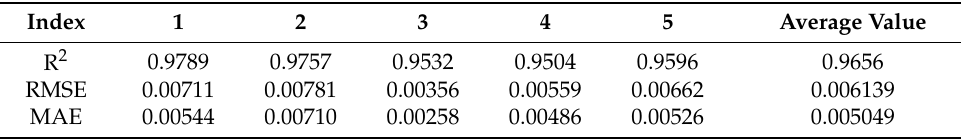
Table 5. Value of the evaluation indices of the five-fold cross-validation for the SVR model on creep.